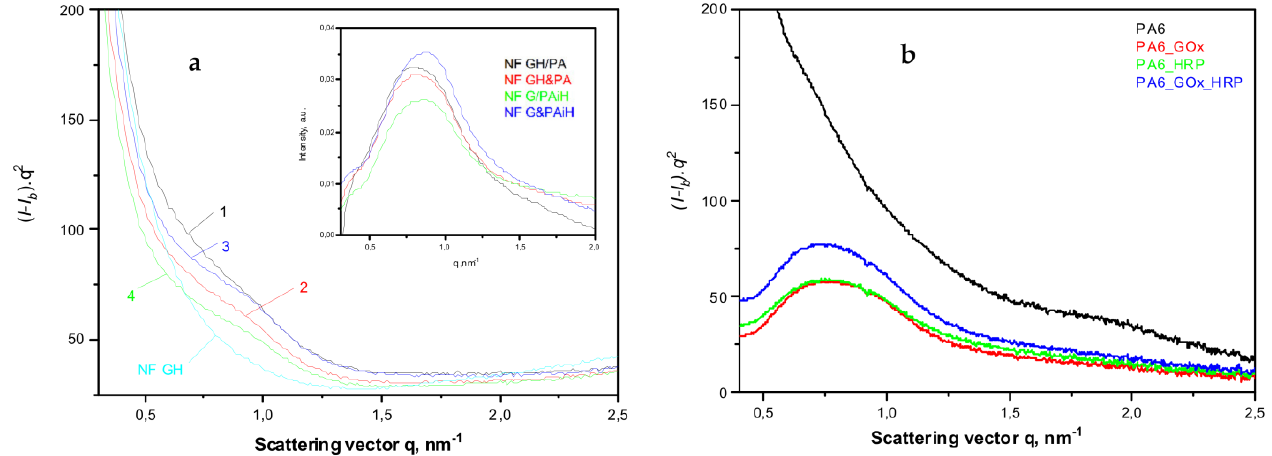
Figure 7. Comparative synchrotron SAXS patterns of: ( a ) NF and PANF; 1 — NF GH/PA; 2 — NF GH&PA; 3 — NF G/PAiH; 4 — NF G&PAiH; ( b ) PA6 MP with immobilized GOx, HRP or a mixed GOx/HRP. The inset represents the SAXS peaks obtained after subtraction of the signal of the NF GH sample from those of the four PANF samples. For more details, see the text.